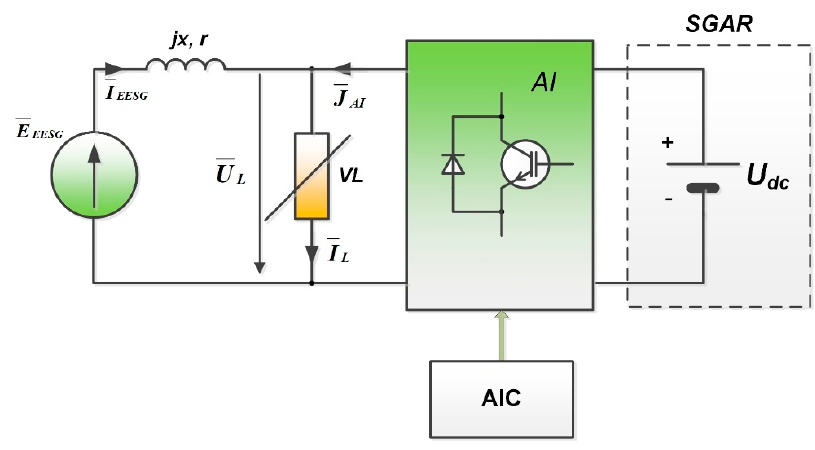
Figure 6. Equivalent circuit of the EESG–AI–SGAR mechatronic system.